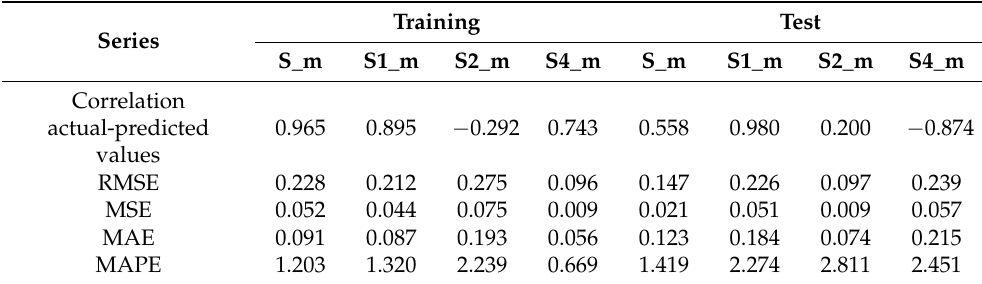
Table 4. The goodness of fit indicators for the best models built for the monthly series with lag 1 and lag 12 variables as